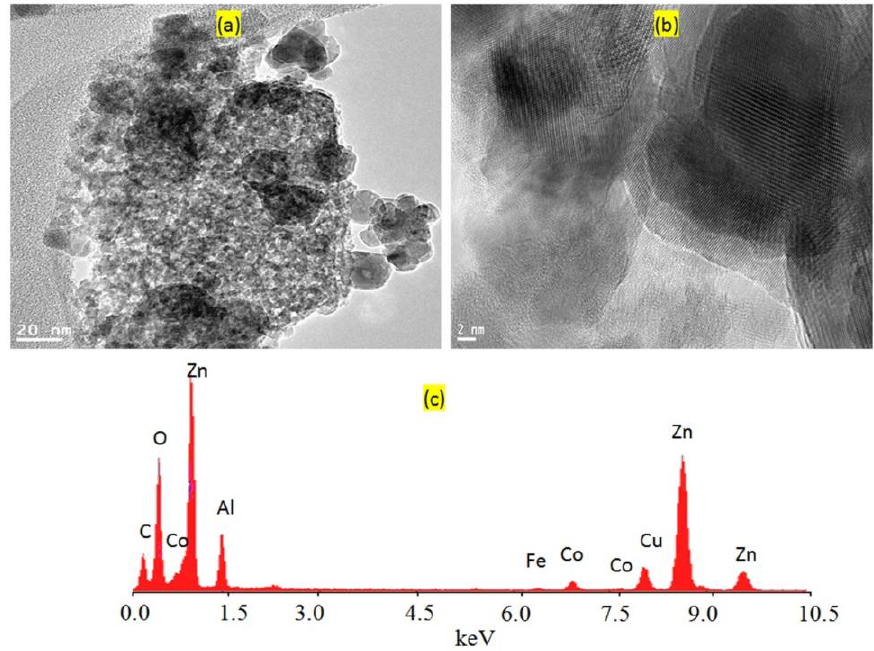
Figure 8. TEM images and EDX of NHZ-1-500: ( a ) 20 nm, ( b ) 2 nm, and ( c ) EDX spectrum.